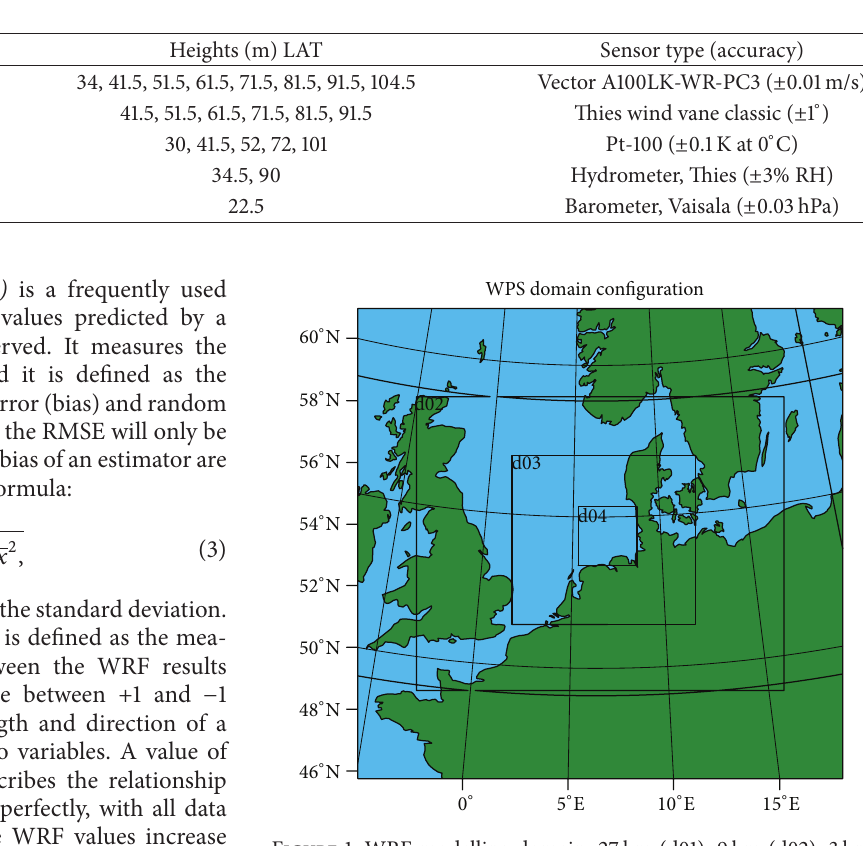
Figure 1: WRF modelling domain: 27 km (d01), 9km (d02), 3 km (d03), and 1km (d04) grid